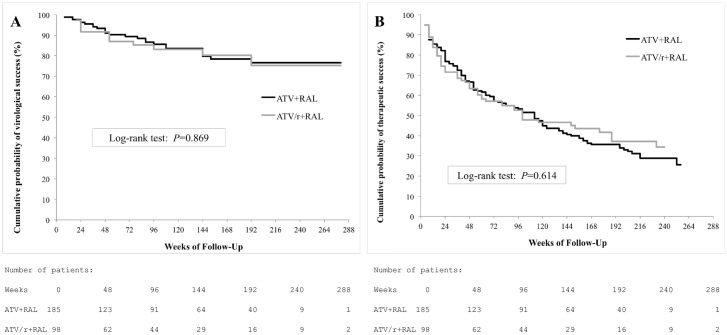
Cumulative probability of treatment success according with ritonavir association.Survival curves by time to loss of virological response analysis, according to virological failure (A) and treatment failure (B). ATV/r or ATV: Boosted or Unboosted Atazanavir, RAL: Raltegravir.